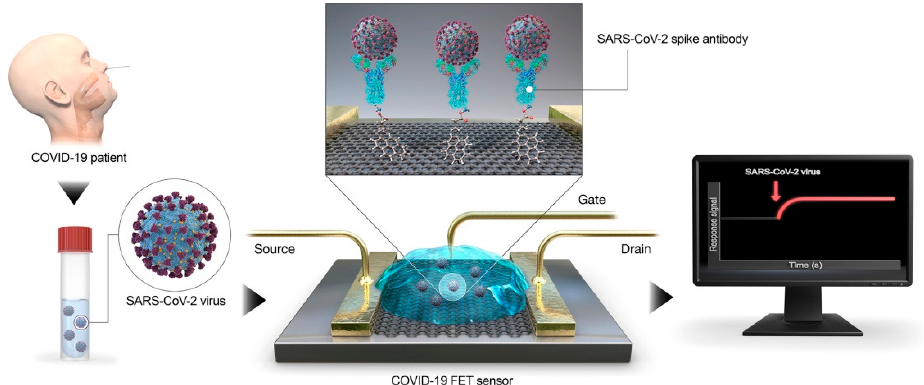
Figure 5. Schematic diagram of COVID-19 FET sensor operation procedure. Reprinted with permission from Seo, G. et al. Rapid Detection of COVID-19 Causative Virus (SARS-CoV-2) in Human Nasopharyngeal Swab Specimens Using Field-Effect Transistor-Based Biosensor. ACS Nano 14(4): 5135–5142. Copyright (2020) ACS [231].